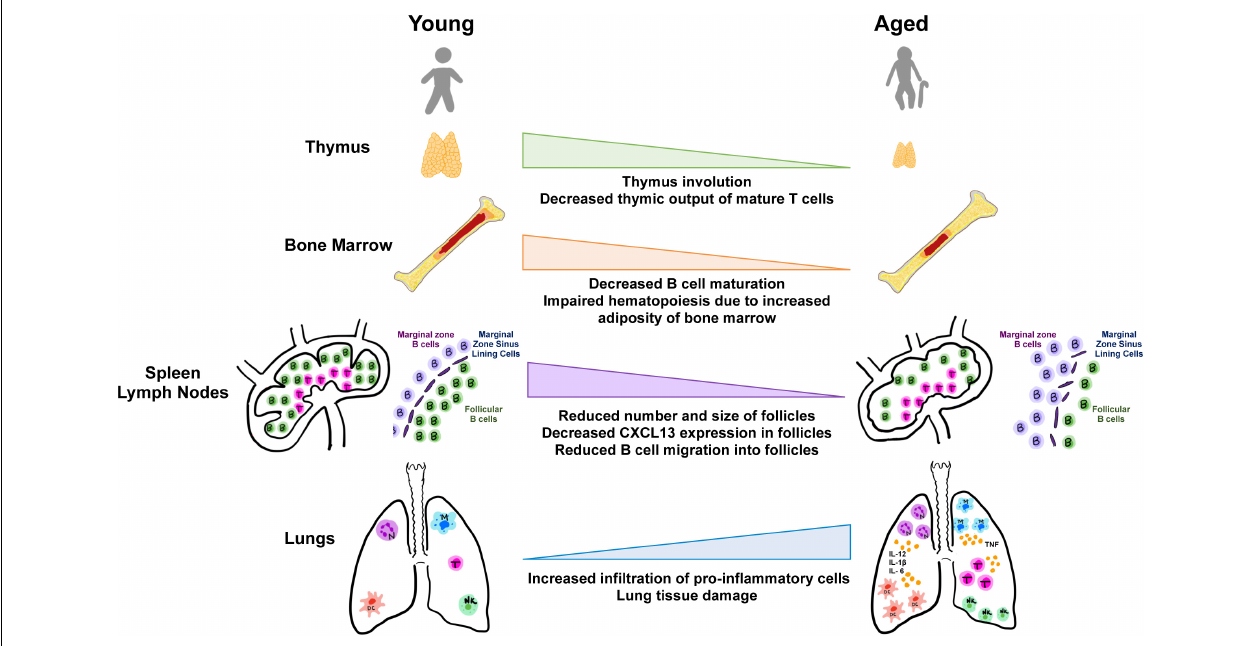
FIGURE 2 | Aging and tissues in immunity. Aging is accompanied by the decline in function of lymphoid and non-lymphoid tissues involved in the host immune response. Degeneration of primary lymphoid organs lowers production of naive T and B lymphocytes which results in reduced migration to secondary lymphoid organs and to sites of antigen encounter. Additionally, the lungs and extrapulmonary organs are susceptible to accumulation of proinflammatory cells and